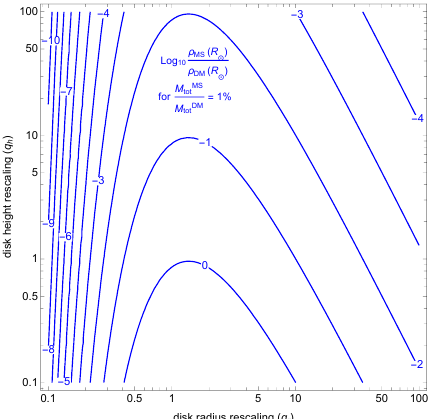
Figure 13. Expected local mirror star mass density relative to local DM density of ρ DM ( R (cid:12) ) = 0 . 3GeV / cm 3 if 1% of DM in our milky way is in the form of mirror stars, and assuming they are distributed in a double-exponential galactic disk distribution with radius and height rescaled by factors q and q relative to the visible milky way disk (see r h